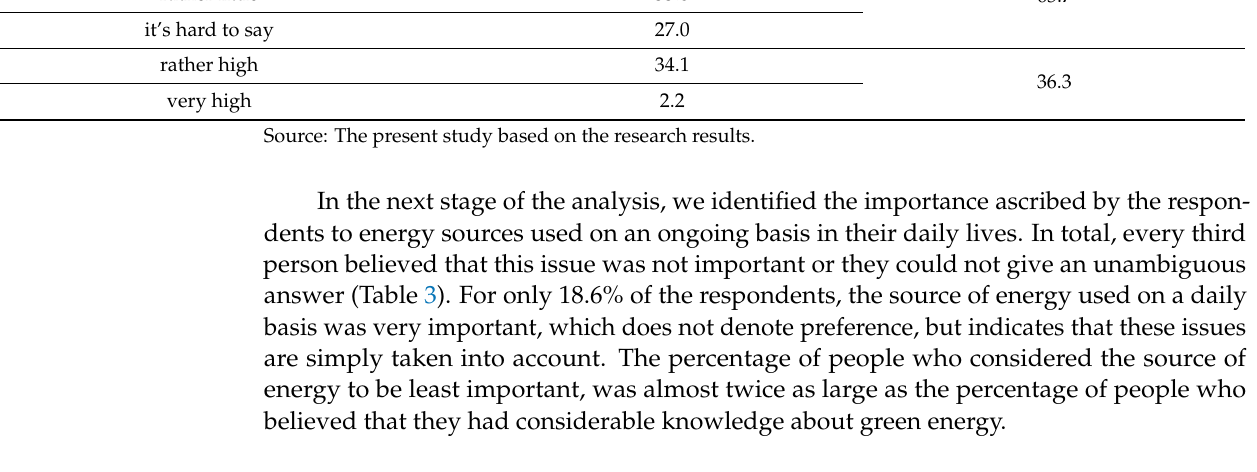
Table 3. Importance ascribed by respondents to the sources of electricity they use on a daily basis